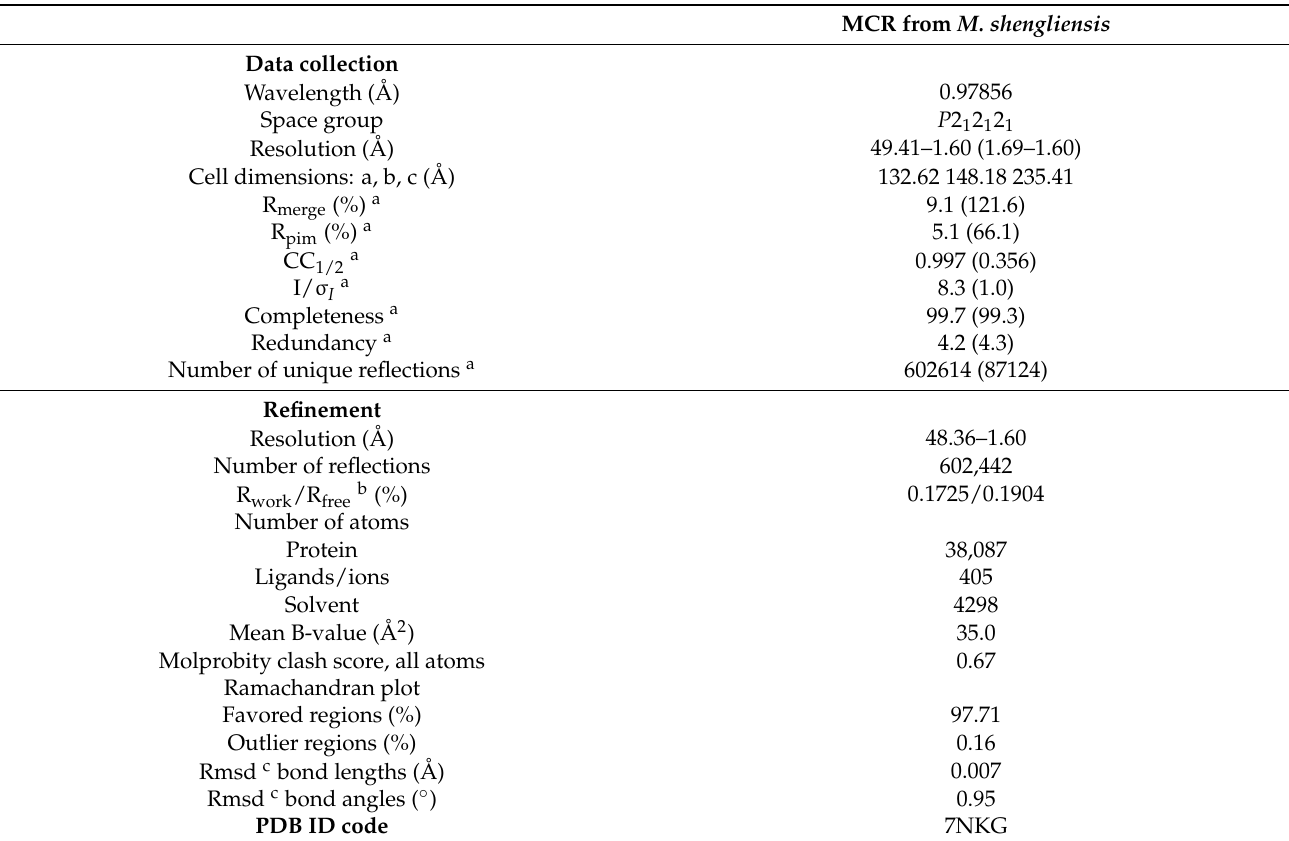
Table 1. X-ray crystallographic data and refinement